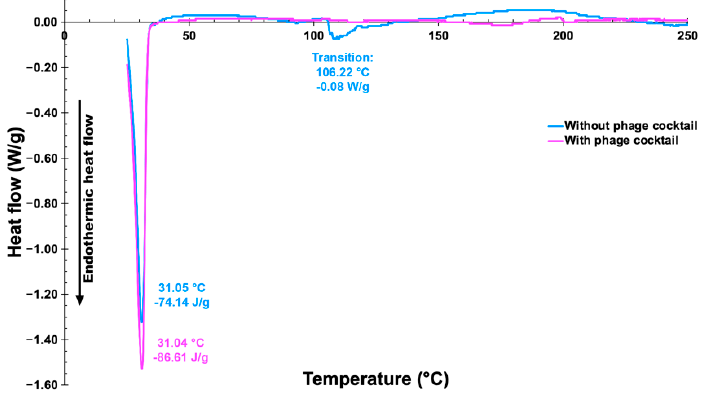
Figure 14. Differential scanning calorimetry thermograms of the plain vaginal egg and of the vaginal egg formulation integrating the phage cocktail.